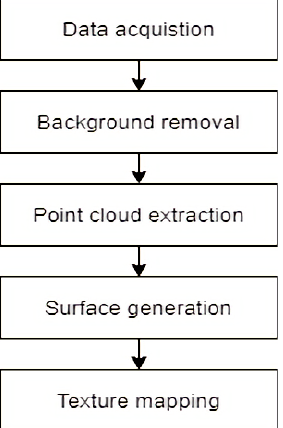
Figure 2. Diagram flow for the 3D reconstruction method.